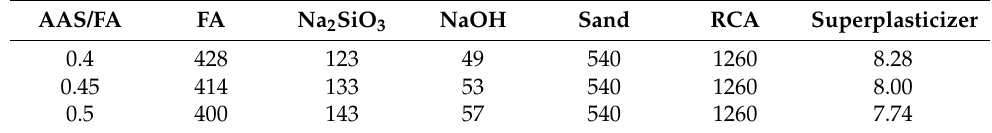
Table 3. Mix proportions of geopolymer recycled aggregate concrete (kg/m 3